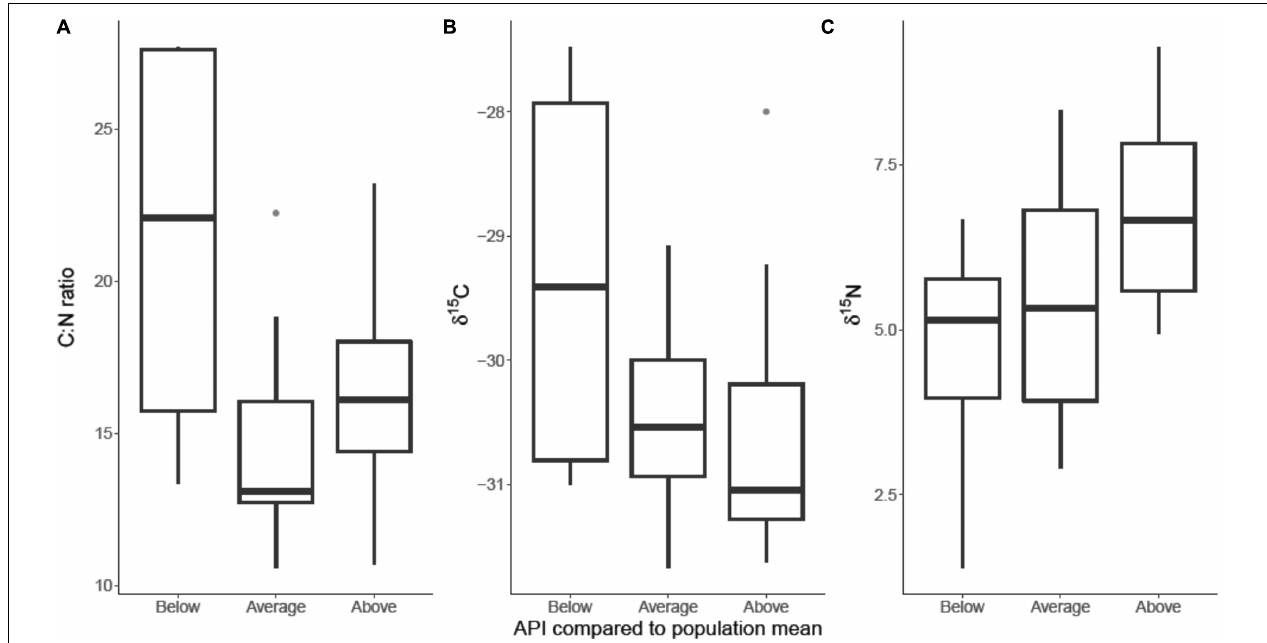
FIGURE 4 | Variation in stable isotope measures (A) C:N ratio, (B) δ 13 C, and (C) δ 15 N associated with body condition of brent geese during the final week of spring staging in Álftanes, Iceland (20/05/2017–27/05/2017). Body condition measured as above, below or at population average for abdominal profile index (API). In week 4 individuals with an above-average API excreted significantly higher δ 15 N values than those with a below-average API ( Tukey post hoc , p =